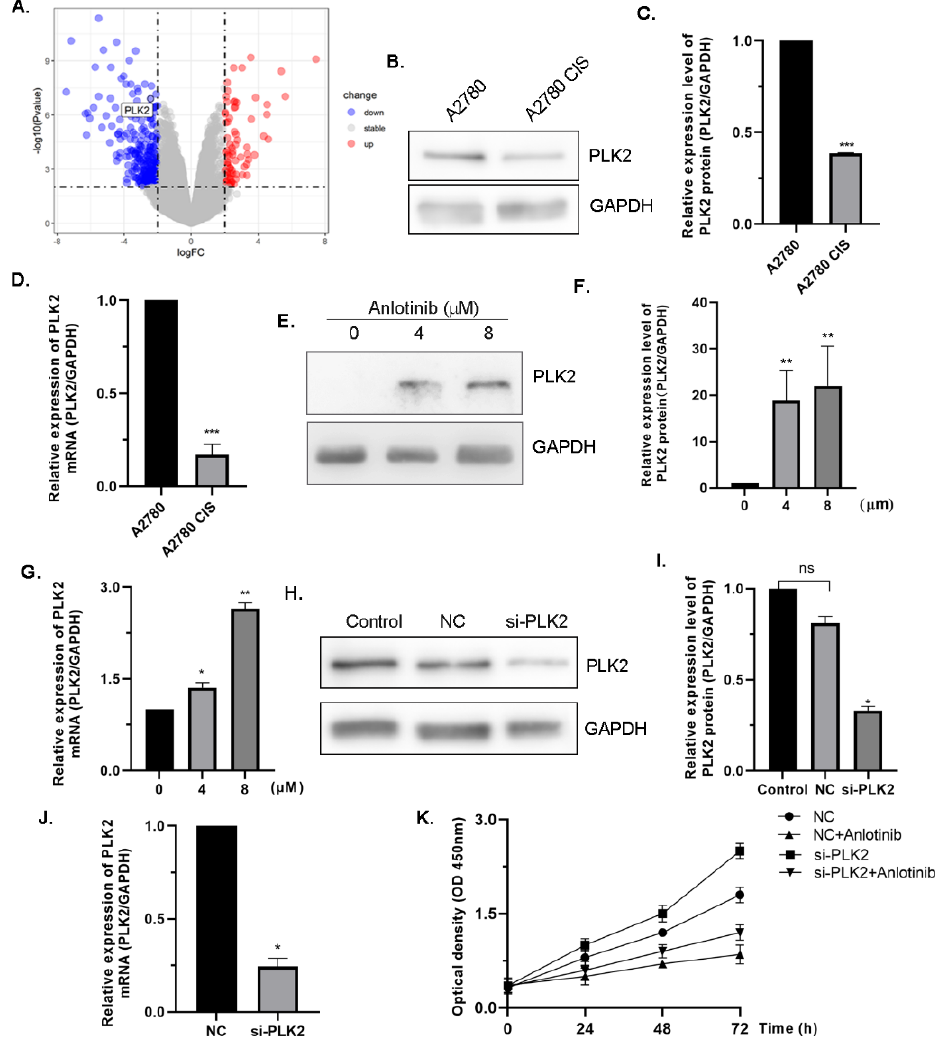
Figure 3. PLK2 is involved in mediating the antiproliferation effect of anlotinib. ( A ) The volcano plot of differentially expressed genes. ( B , C ) Western blot analysis of PLK2 in A2780 and A2780 CIS cells ( B ) and the statistical analysis of the change in PLK2 protein ( C ). ( D ) qRT-PCR analysis of PLK2 in A2780 and A2780 CIS cells. ( E , F ) Western blot analysis of PLK2 in A2780 CIS cells treated with anlotinib ( E ) and the statistical analysis on the change of PLK2 protein ( F ). ( G ) qRT-PCR analysis of PLK2 in A2780 CIS cells treated with anlotinib. ( H – J ) The knockdown efficiency of PLK2 in A2780 CIS cells was assessed via qRT-PCR ( G ) and Western blot ( H , I ). ( K ) CCK8 assay detected cell growth under different treatment conditions. All experiments were performed in at least three biological replicates, and each biological replicate contained three technical replicates. Student’s t -test was used to compare values between control and different treatment groups. * p < 0.05, ** p < 0.01 and *** p < 0.001 vs. control.